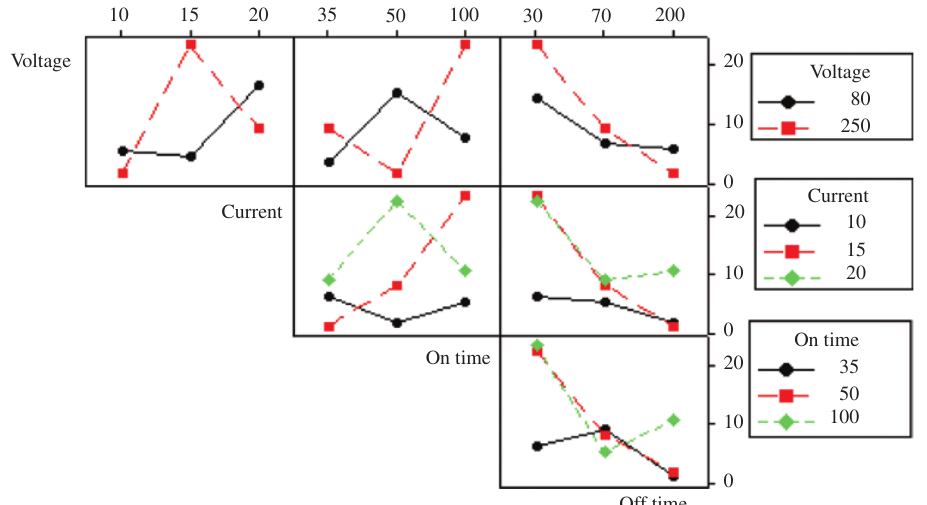
Figure 7: Interaction plot for the process parameters on MRR in the machining of 2024